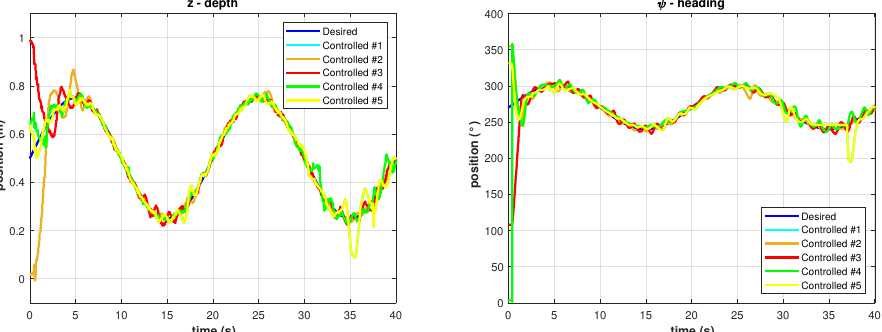
Figure 9. Controlled trajectories with the asymptotic model-free 2nd-order SMC. ( Left ) Depth. ( Right ) Heading.